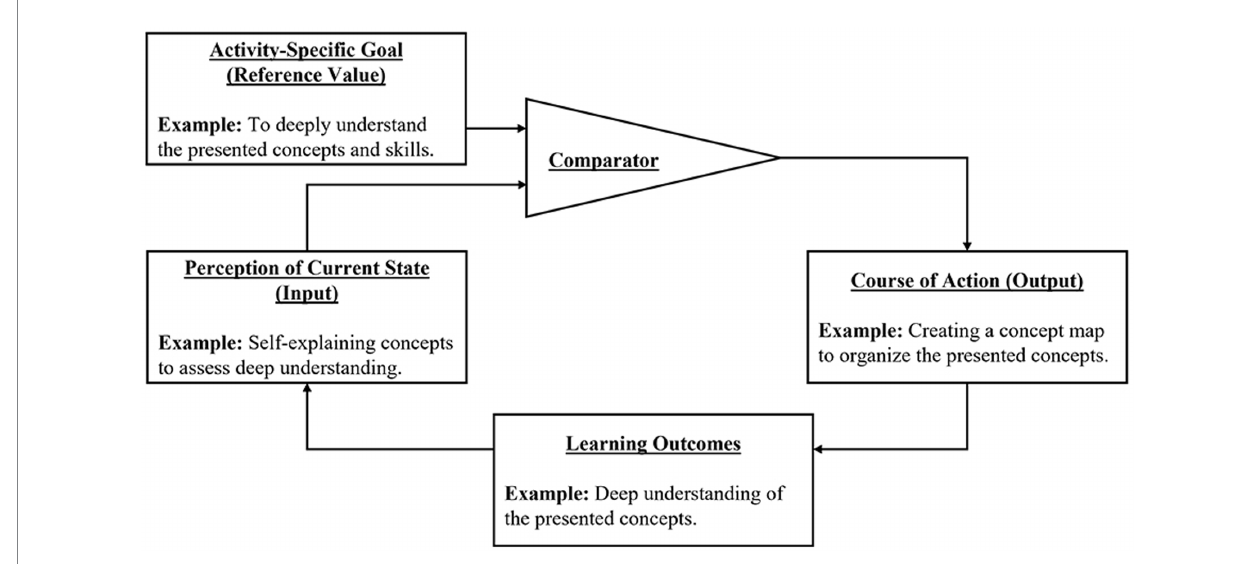
FIGURE 1 Schematic of a discrepancy-reducing feedback loop [adapted from Carver (2015), with